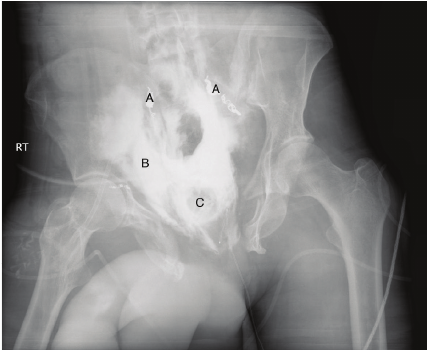
Figure 2: Cystogram demonstrating extravasation and contrast and urine out of the bladder. A: embolization coils in bilateral internal iliac arteries. B: extravasation of contrast outside of the bladder. C: suprapubic tube balloon.